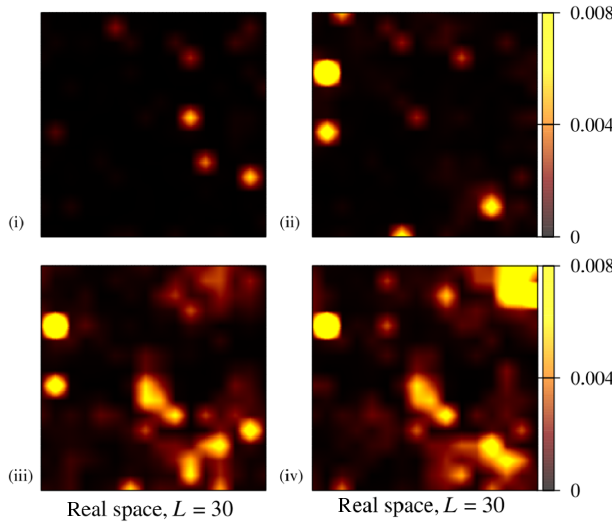
ð R Þ for sample α at Z ¼ 10 000 , FIG. 12. Distance fields Δ α ab using the four pairs of clones shown in Fig. 11(d). From (i) to (iv), the various levels of the hierarchy of states are associated to larger displacements and longer-ranged spatial